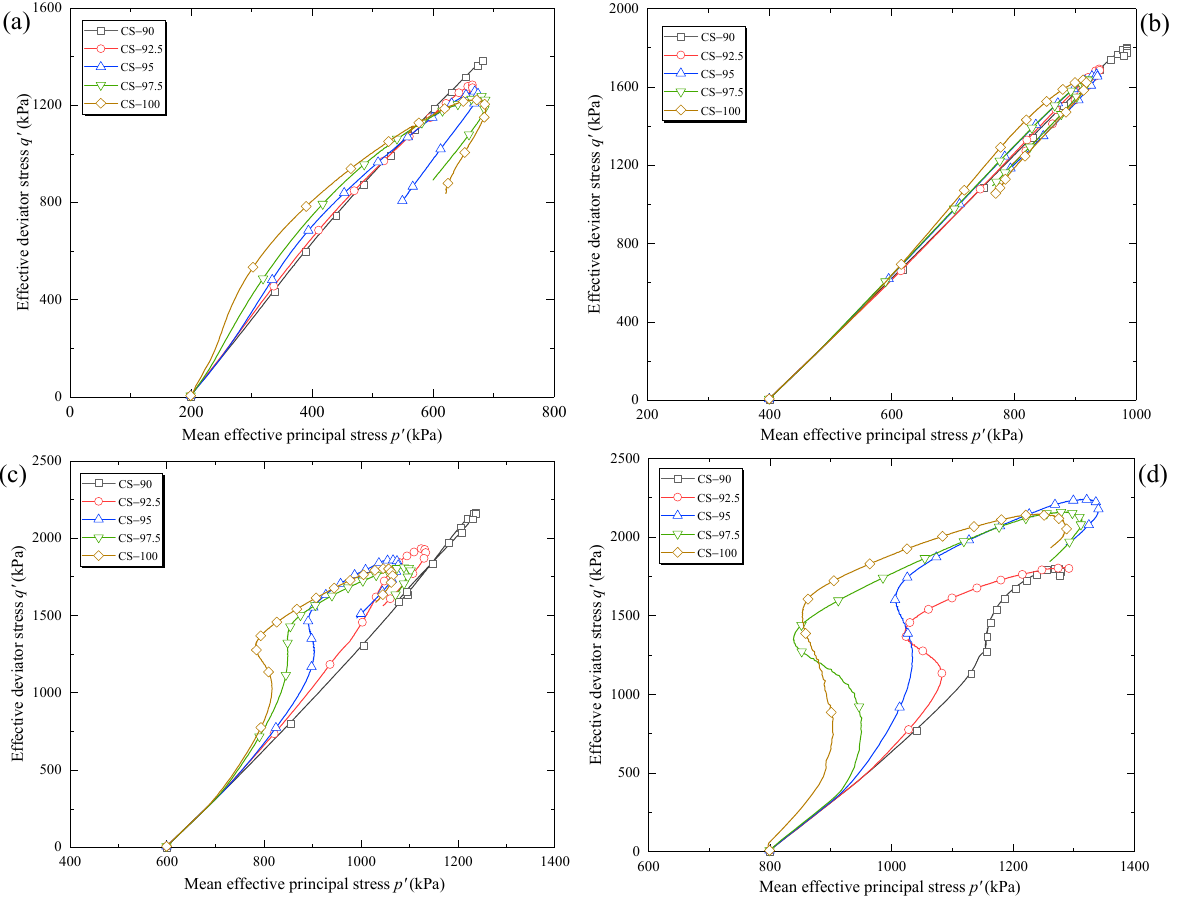
Figure 8. Stress path of coral sand with different saturations: ( a ) σ 3’ = 200 kPa; ( b ) σ 3’ = 400 kPa; ( c ) σ 3’ = 600 kPa; ( d ) σ 3’ = 800 kPa.